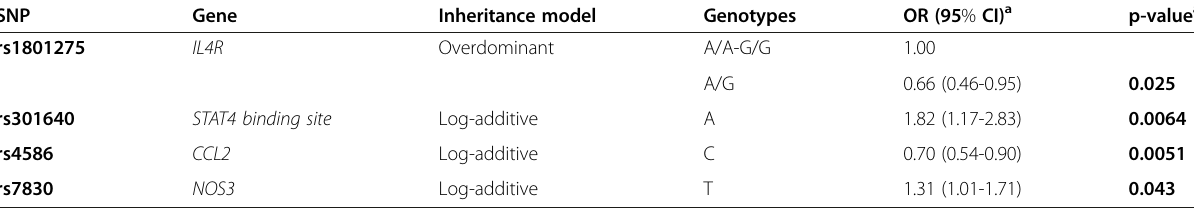
Abbreviations: ESRD, end-stage renal disease; IL4R, interleukin 4 receptor; STAT4 signal transducer and activator of transcription 4; CCL2, chemokine (C-C motif) ligand 2; NOS3 nitric oxide synthase 3; OR, odds ratio; 95%CI, 95% confidence interval; p-value, level of significance. a OR and p-value of adjusted model by age and